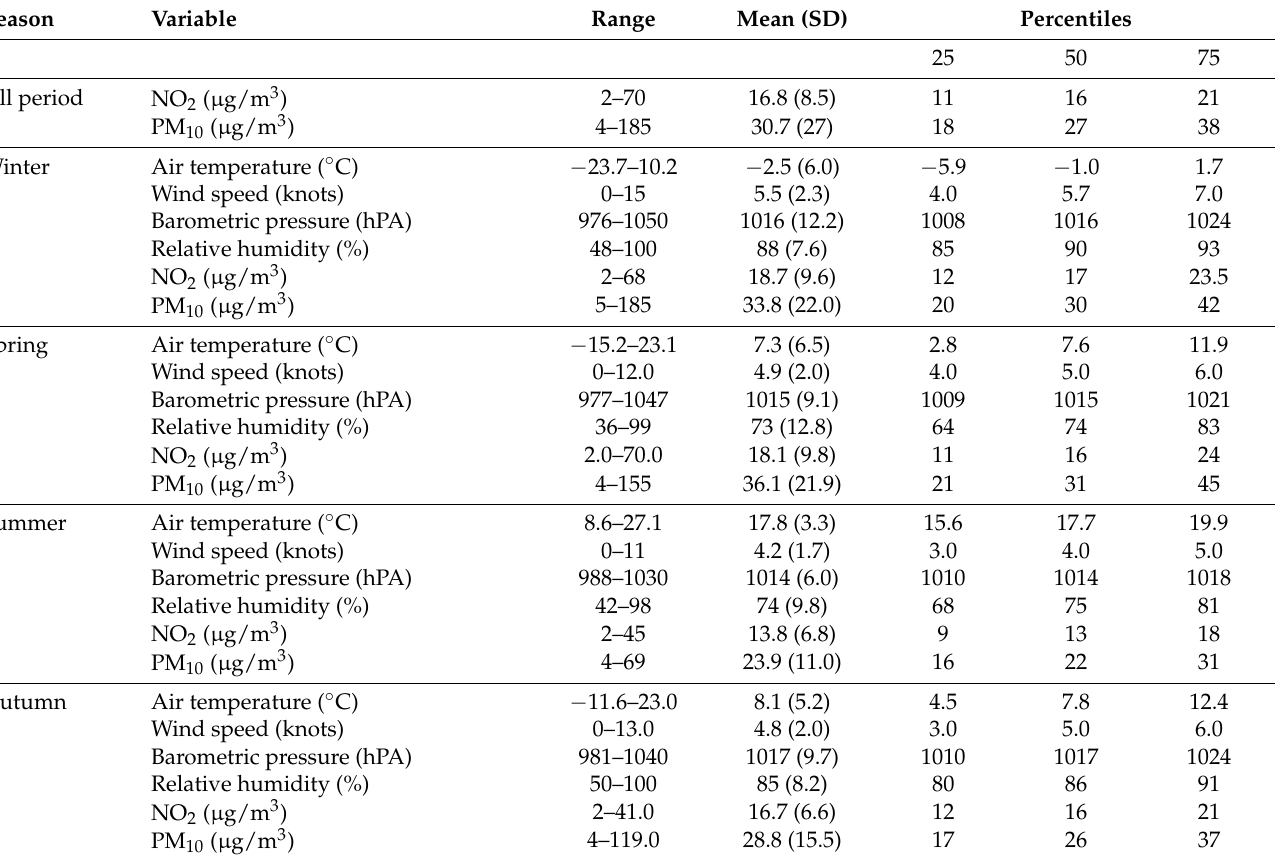
Table 2. Descriptive characteristics of the daily environmental variables in Kaunas during the study period 2006–2015, by season.